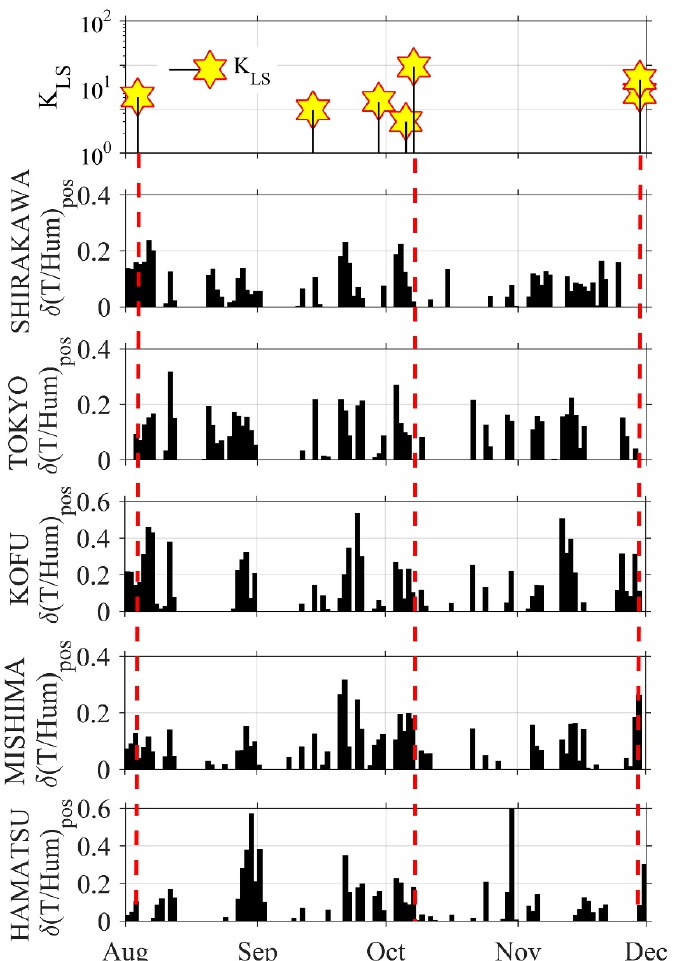
Figure 6. The evolution of the local seismicity (for Tokyo) and variations of the ratio of temperature- to-humidity at five meteorological stations. A best correlation with seismicity is observed at the Mishima (MIS) and Kofu (KOU) stations, where peaks have a lead time of 2–3 weeks) before the Tokyo EQ exceeds all other ones. The unit of T / Hum is °C/%.